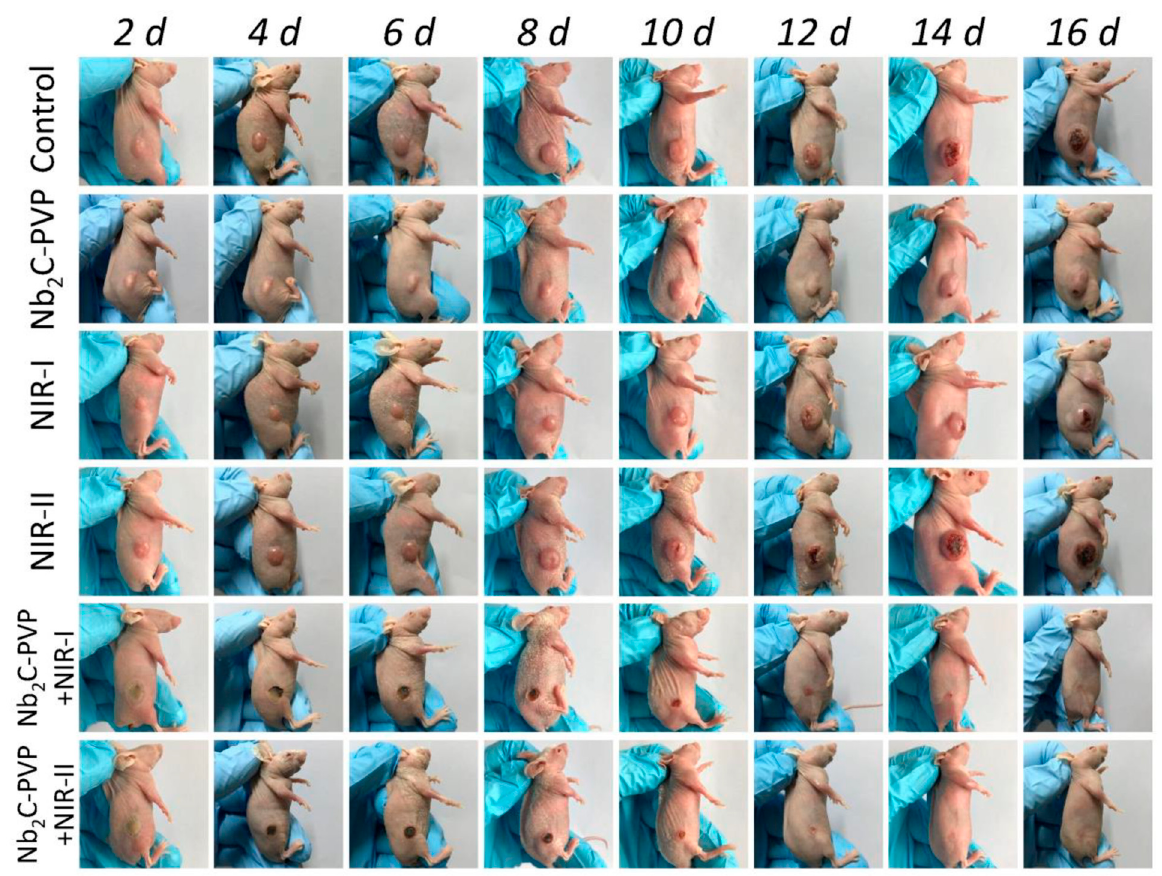
Figure 13. Photographs of 4T1 tumor-bearing mice after the control and different treatments in 16 days’ period. Reprinted with permission from Ref. [90].